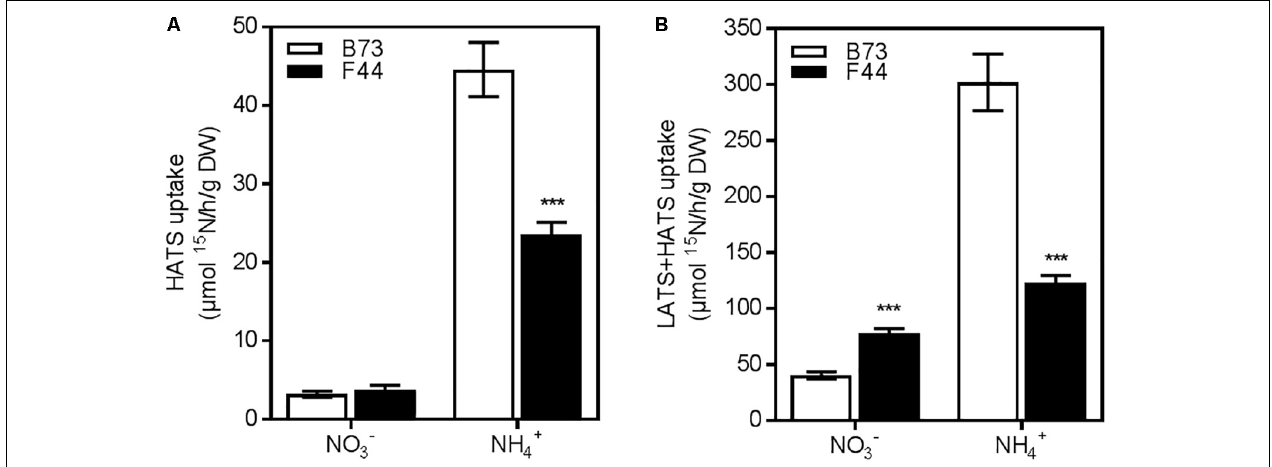
FIGURE 1 | Nitrogen uptake capacity of B73 (white) and F44 (black) root systems. (A) High affinity transport (HATS) of 50 µ M of nitrate (NO 3 − ) or ammonium (NH 4 + ). (B) Low affinity transport (LATS+HATS) of 2.5 mM of nitrate (NO 3 − ) or ammonium (NH 4 + ). Values are means ( ± SE) from six individual plants. Similar results were obtained in three other independent experiments. Asterisks indicate significant differences between lines at ∗∗∗ P < 0.005 (Student’s t -test).